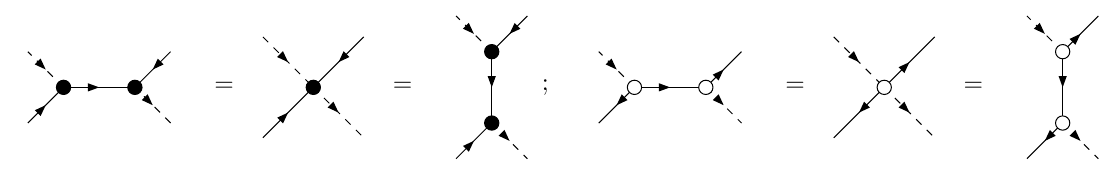
Figure 1 . Merging rules for N = 7 on-shell diagrams. The decorated edges must appear opposite.